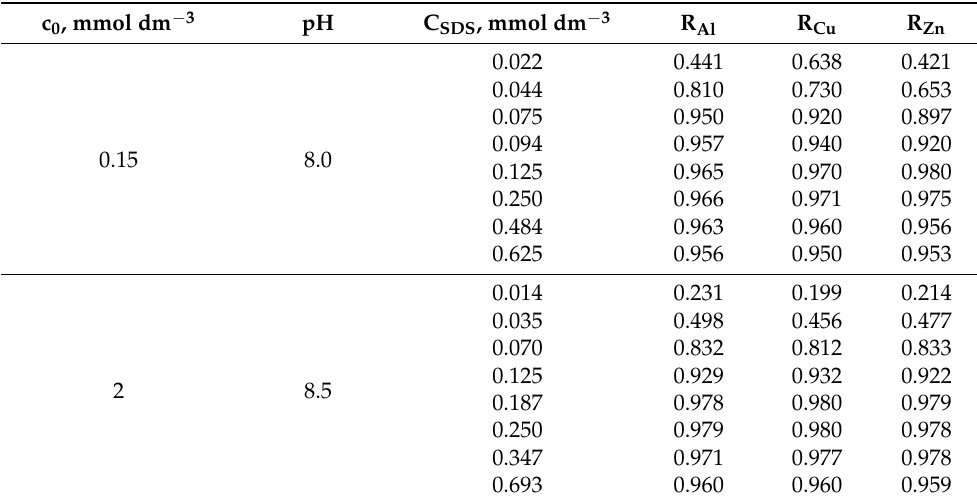
Table 4. Effect of the collector concentration on the efficiency of simultaneous precipitate flotation of Al(III), Cu(II), and Zn(II)